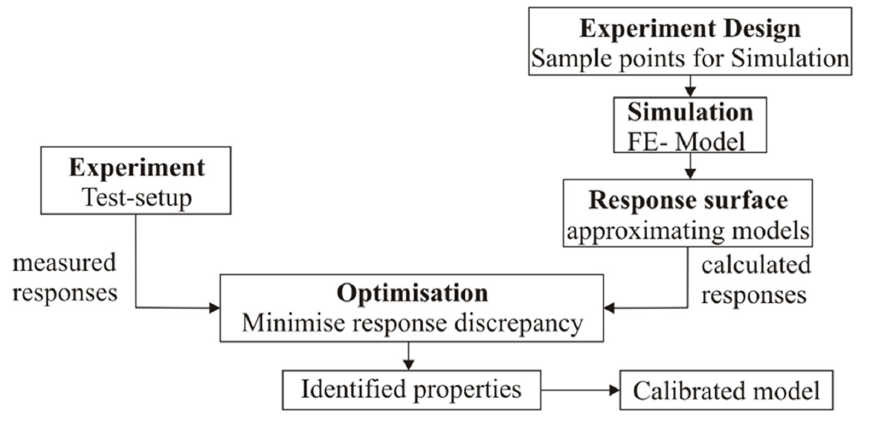
Figure 4. Calibration method of the numerical model [41].